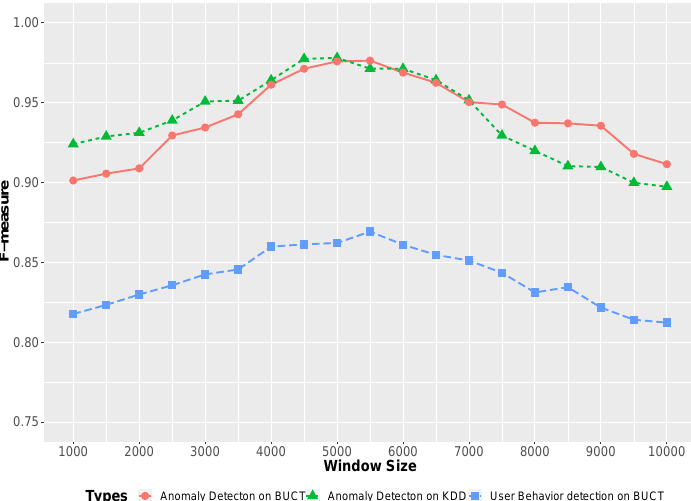
Figure 6. F-measure with different window